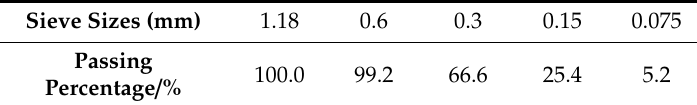
Table 6. The Gradation of Crumb